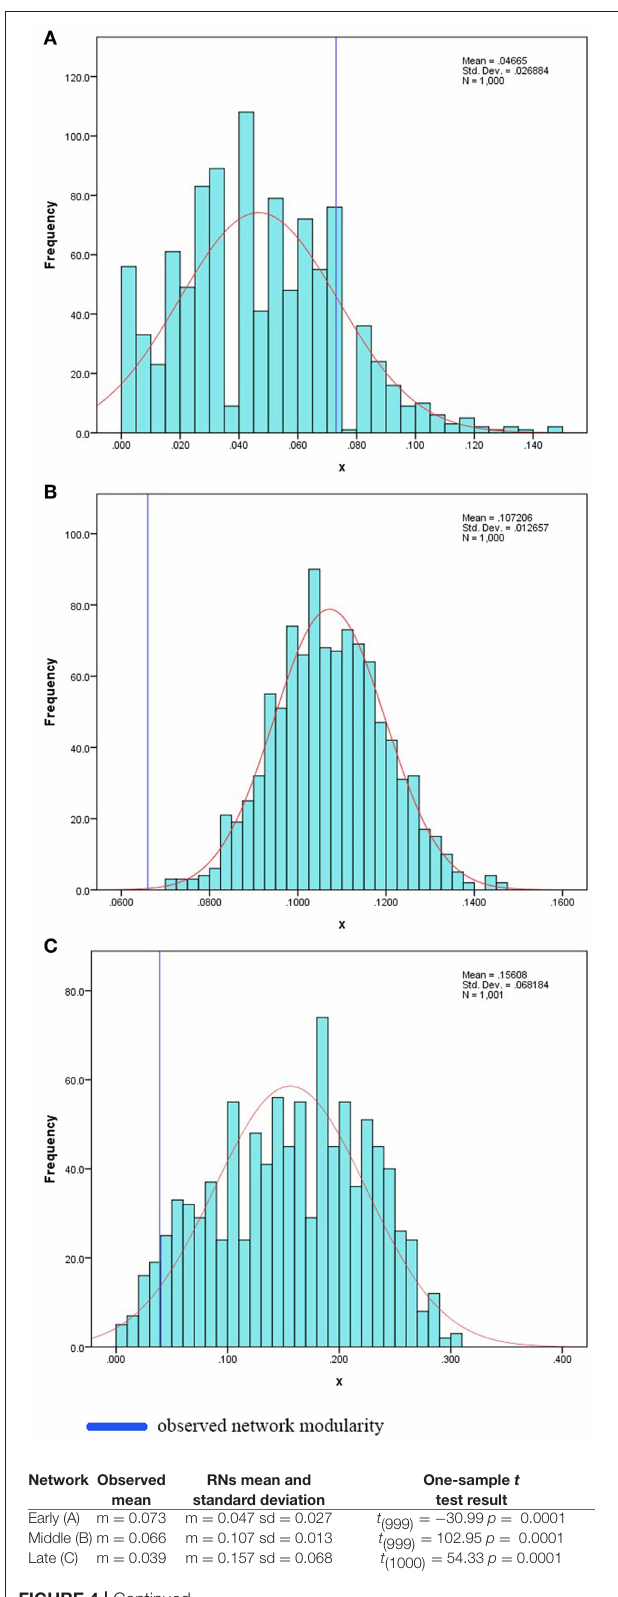
FIGURE 4 | Frequencies of RNs Louvain maximum modularity scores compared to the result obtained on the three empirical networks ( A early network; B middle network, C late network). The blue vertical line marks the modularity value calculated on the observed early, middle and late networks. The Q max value of the early buildings network appears to be statistically significantly higher than the mean of the distribution of the RNs modularity, in contrast both the Q max score of the observed middle and late networks are significantly lower than the mean of the RN Q max distributions.